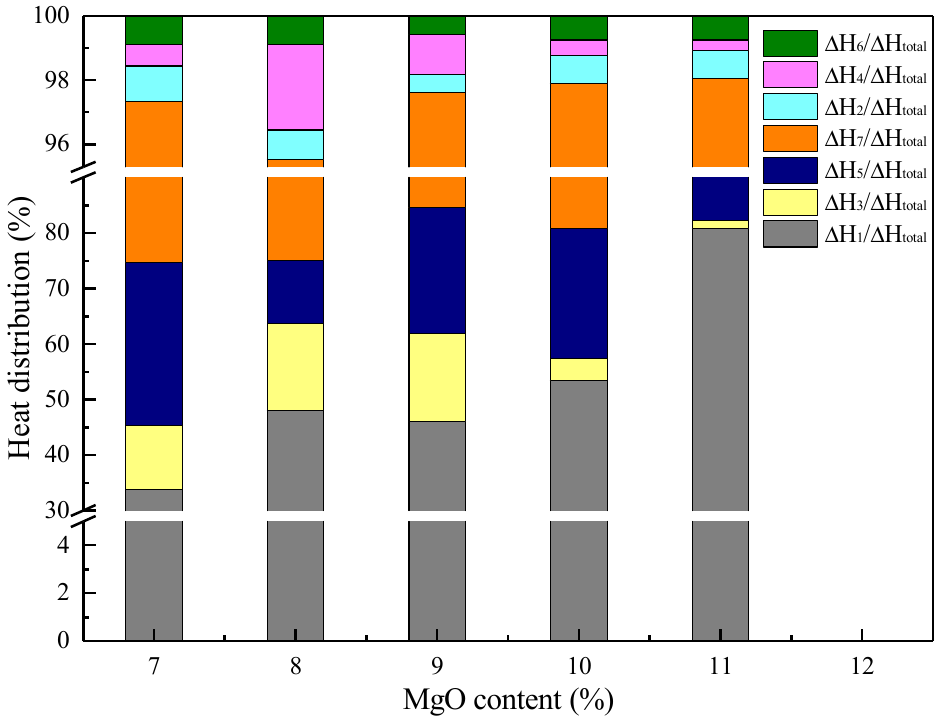
Figure 6. Distribution of heat released in each stage of BF slag cooling.